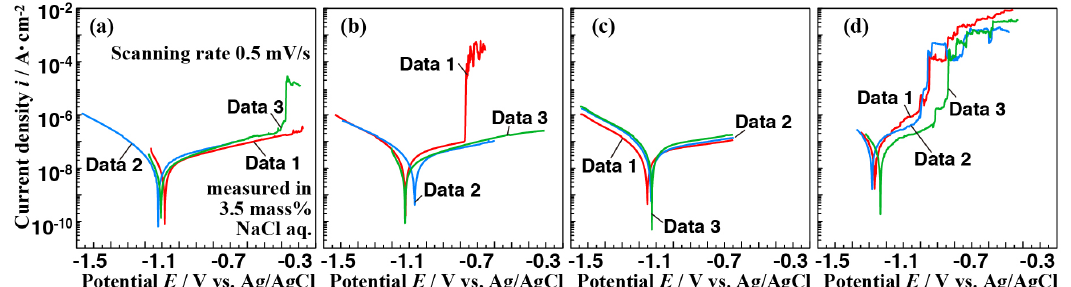
Figure 9. Potentiodynamic polarization curves of the anticorrosive film coated on the AZ61 substrate under different treatment conditions: ( a ) 0.25, ( b ) 0.32, ( c ) 0.42, and ( d ) 0.54 MPa in 3.5 mass% NaCl aqueous solution.